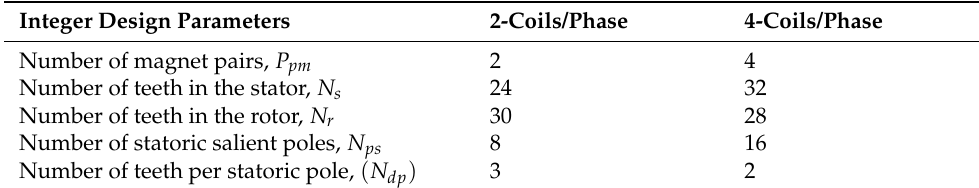
Table 2. Integer design parameters of the studied machines. Integer Design